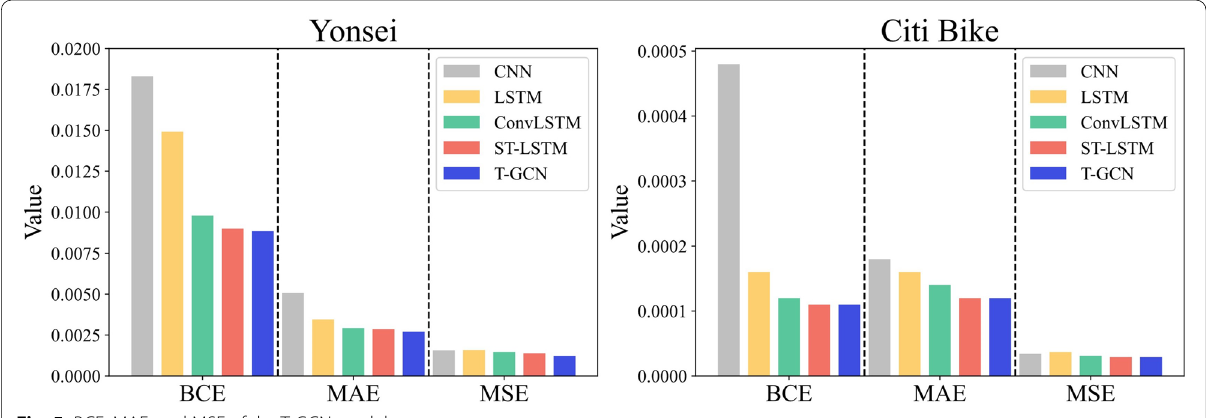
Fig. 5 BCE, MAE, and MSE of the T-GCN model